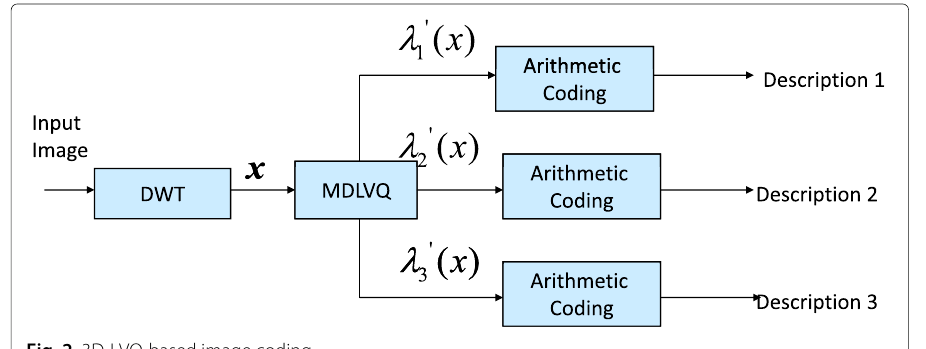
Fig. 2 3D-LVQ-based image